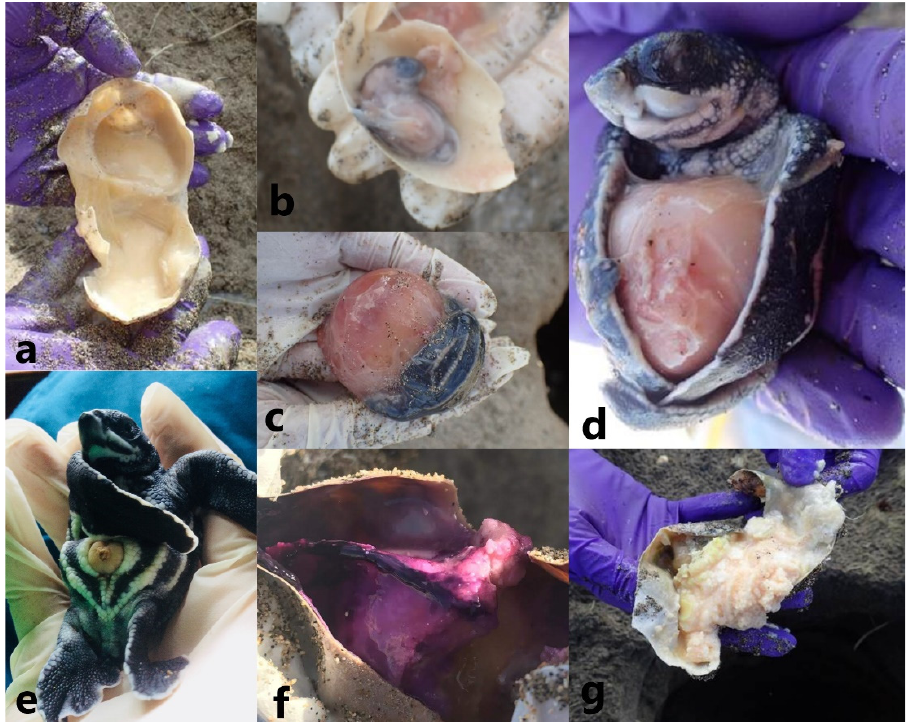
Figure 2. Leatherback sea turtle ( Dermochelys coriacea ) egg development stages used to characterize embryonic development success and selected observed gross changes. ( a ) No gross signs of development and variously staged embryo development at ( b ) < 5 mm, ( c ) 5 mm–2 cm, and ( d ) >2 cm in size and ( e ) full term. Embryos were examined for pathologic changes consisting of yolk discolouration ( f ) and/or (g) yolk inspissation, (photo credit KEC).